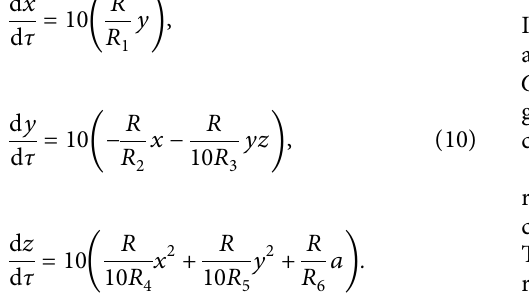
C In Figure 8, R is the timescale transformation factor. 0 0